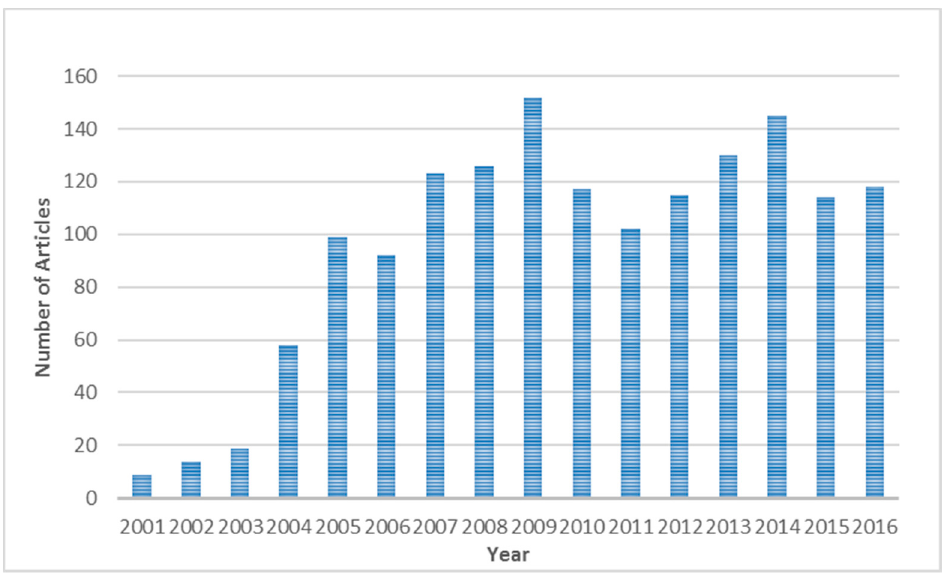
Figure 1. The number of articles published on geographic information ontology from 2001 to